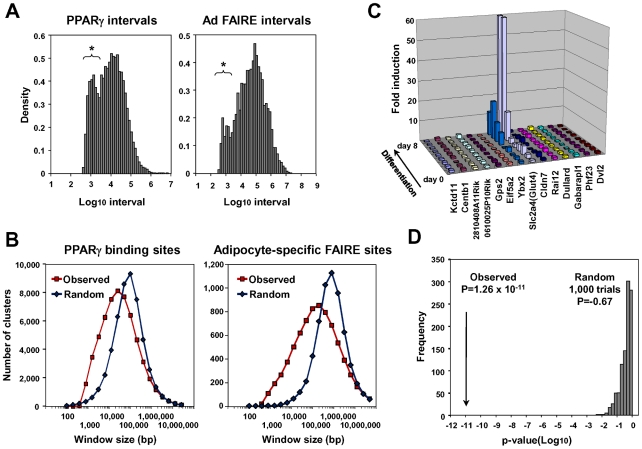
Statistical analyses for clustering of adipocyte-specific FAIRE peaks and PPARγ binding sites and co-regulation of neighbor genes during adipogenesis.(A) Histogram showing distribution of intervals (defined as distances to the nearest neighbor sites) among all PPARγ peaks (left) and among the adipocyte-specific FAIRE peaks (right). Note that there was increased occurrence of sites separated by short intervals (indicated by asterisks). See [48] for details of the method. (B) Clustering analysis of the PPARγ binding sites and the adipocyte-specific FAIRE peaks by counting the total number of clusters (defined as more than two peaks) determined for windows with indicated width. The PPARγ binding site or adipocyte-specific FAIRE peak clusters occurred more frequently in the observed data set than in random data with the same number of sites. The difference in the number of clusters was observed at window sizes ranging from 800 bp to 30∼100 kb compared with the random sample. See reference [47] for details of the method. (C) Microarray analysis showing both Slc2a4 (Glut4) and Ybx2 included in the adipocyte-specific FAIRE peak cluster (Figure S2C) co-regulated during differentiation. (D) Neighbors of highly induced genes (>10 fold) were more likely to be up-regulated over three fold (18%, or 112 of 618 neighbors) than the 2,012 of 21,343 total genes (9%) that were up-regulated over three fold (p = 1.26×10−12, one-sided Fisher test). Neighbors of randomly selected genes were not significantly up-regulated (p = −0.67, average of 1,000 trials). See reference [50] for method.